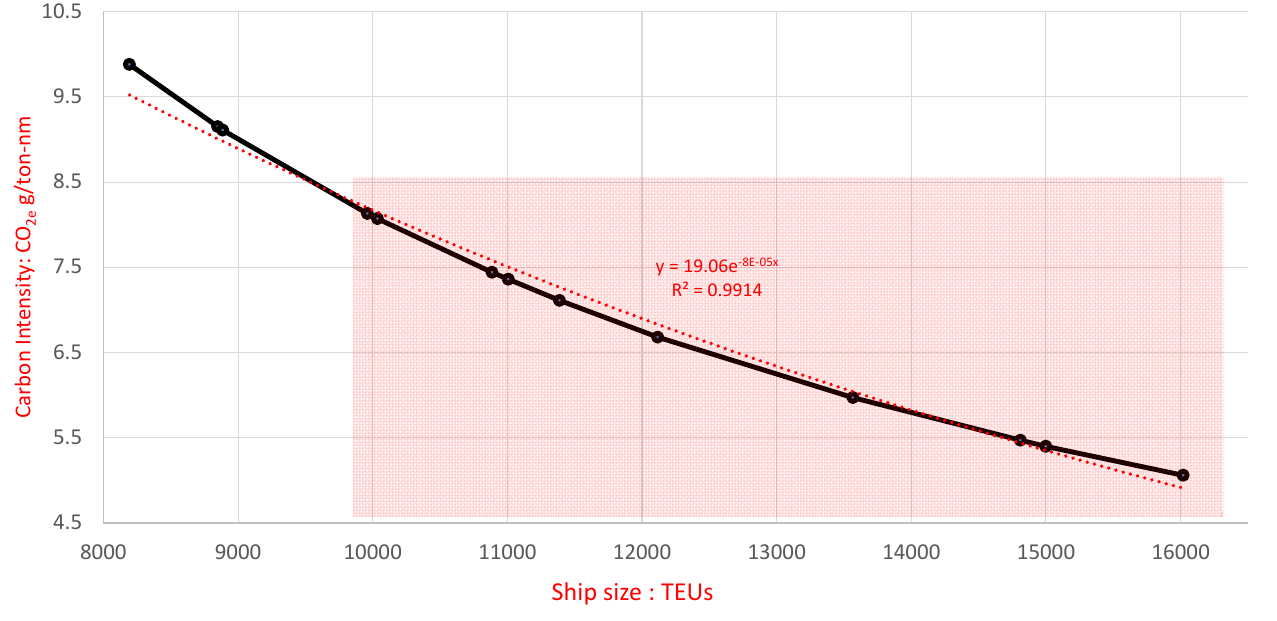
Figure 4. The Carbon Intensity against Ship Size of Route B-1.